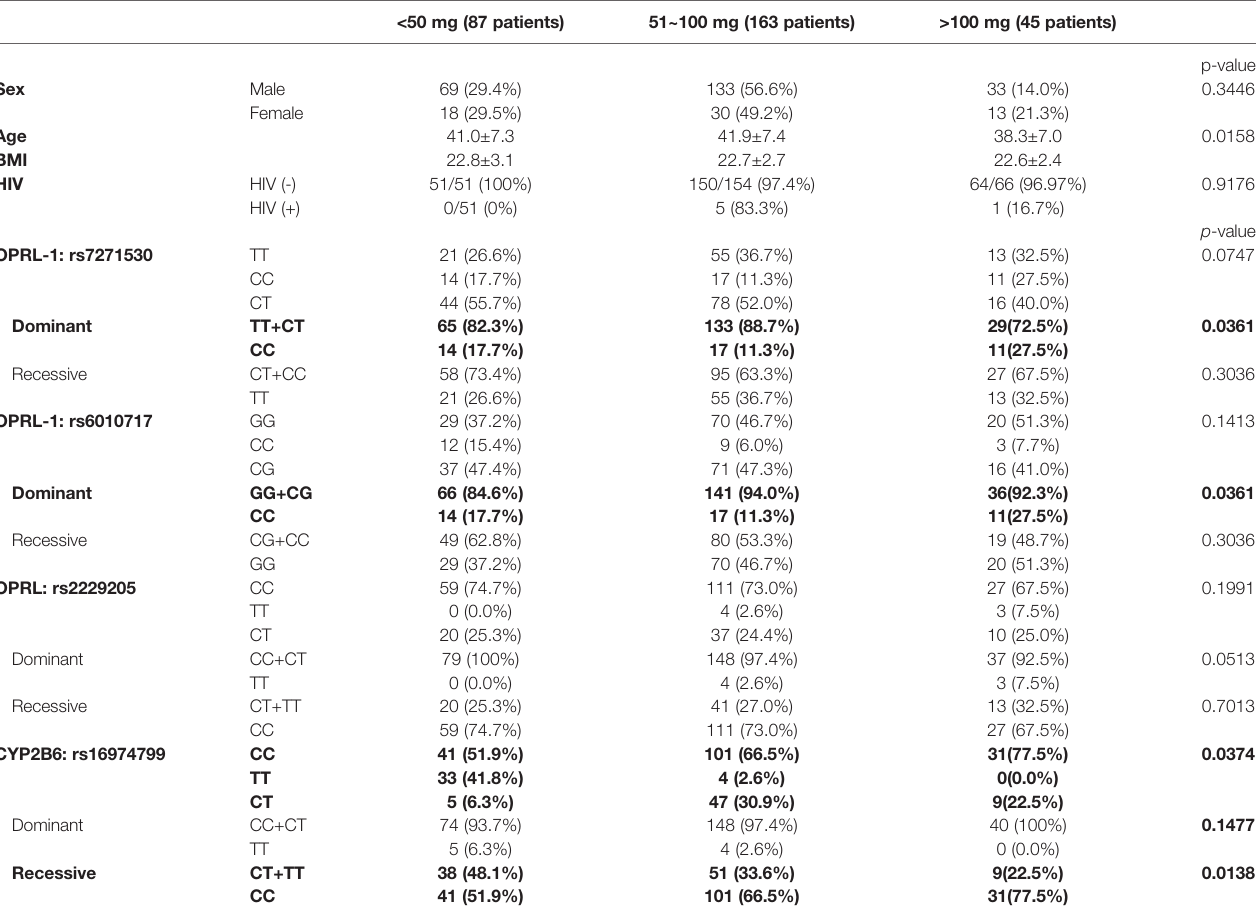
TABLE 1 | Demograph of MMT cohort in association of SNP and MMT